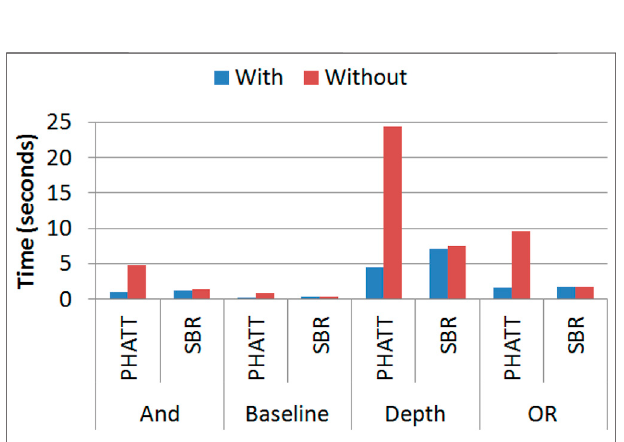
FIGURE 14 | A comparison of runtime (in seconds) with and without using the Matching